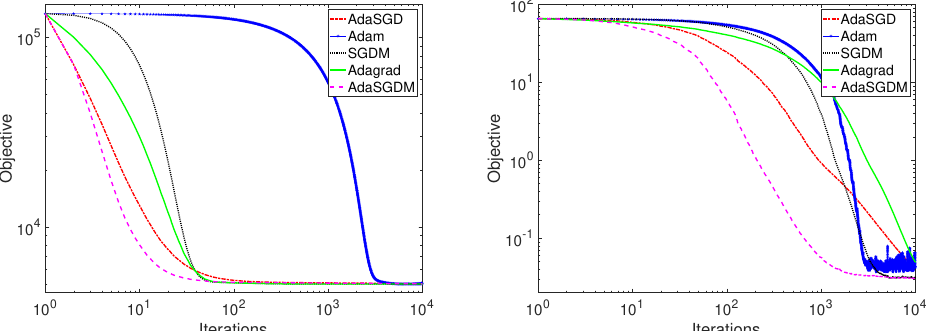
Figure 2. The convergence paths of the algorithms SGDM, Adam, and Adagrad and the proposed methods AdaSGD and AdaSGDM when m = 10,000, n = 200, and the objective functions are smooth convex functions. Left : the objective function f 1 ( x ) ; Right : the objective function f 2 ( x )